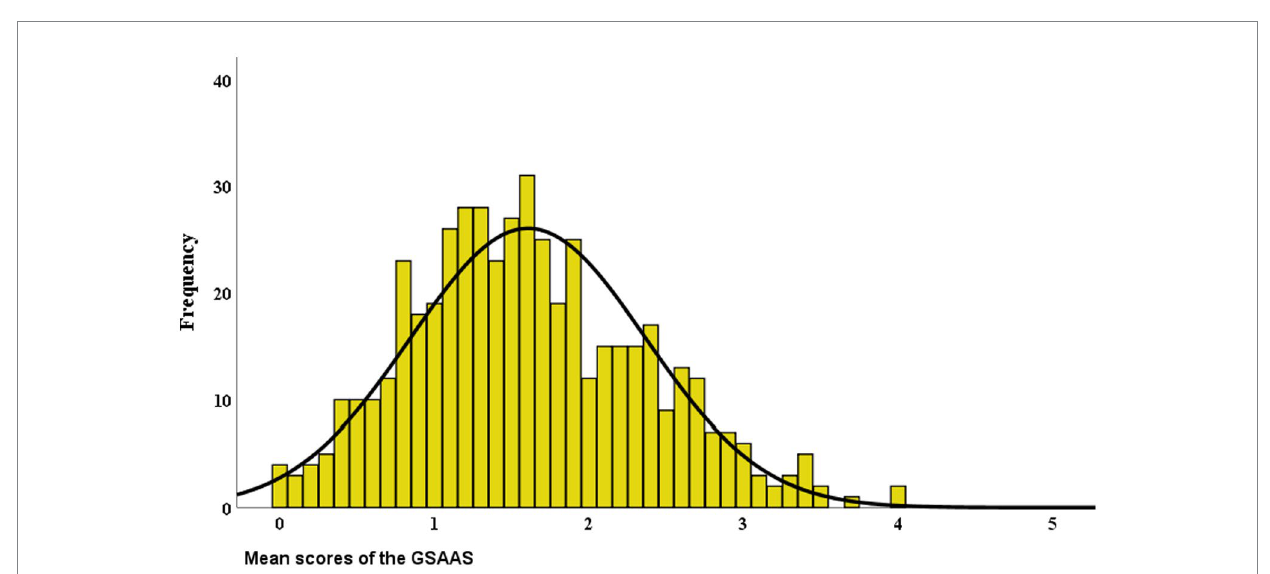
FIGURE 2 Frequency distribution of the mean scores of the GSAAS ( N =